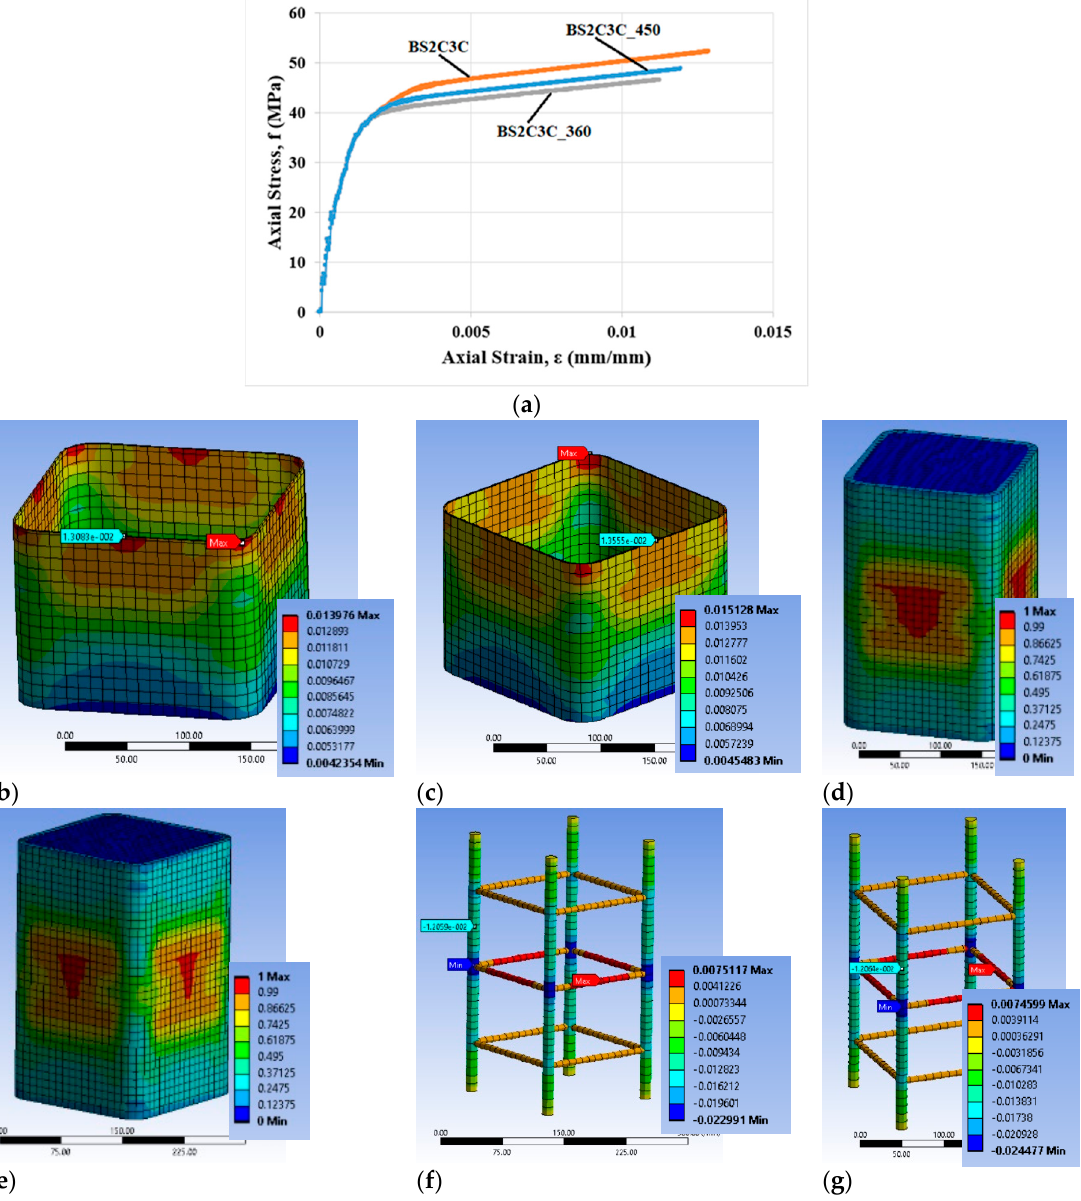
Figure 16. ( a ) FE analysis predictions versus experimental stress-strain results for the parametric study of specimen BS2CL3; variation of the CFRP strain and characteristic values of specimen ( b ) BS2C3C_360 at the level of the middle stirrup and ( c ) BS2C3C_450 at the level of the middle stirrup; variation of concrete damage of specimen ( d ) BS2C3C_360 at the ultimate condition and ( e ) BS2C3C_450 at the ultimate condition; variation of ε stirrup_max , ε long_mid and ε long_min for specimen ( f ) BS2C3C_360 and ( g ) BS2C3C_450.